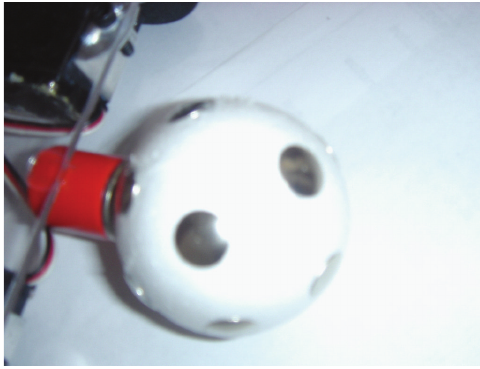
Figure 18: A robot taking an object with the